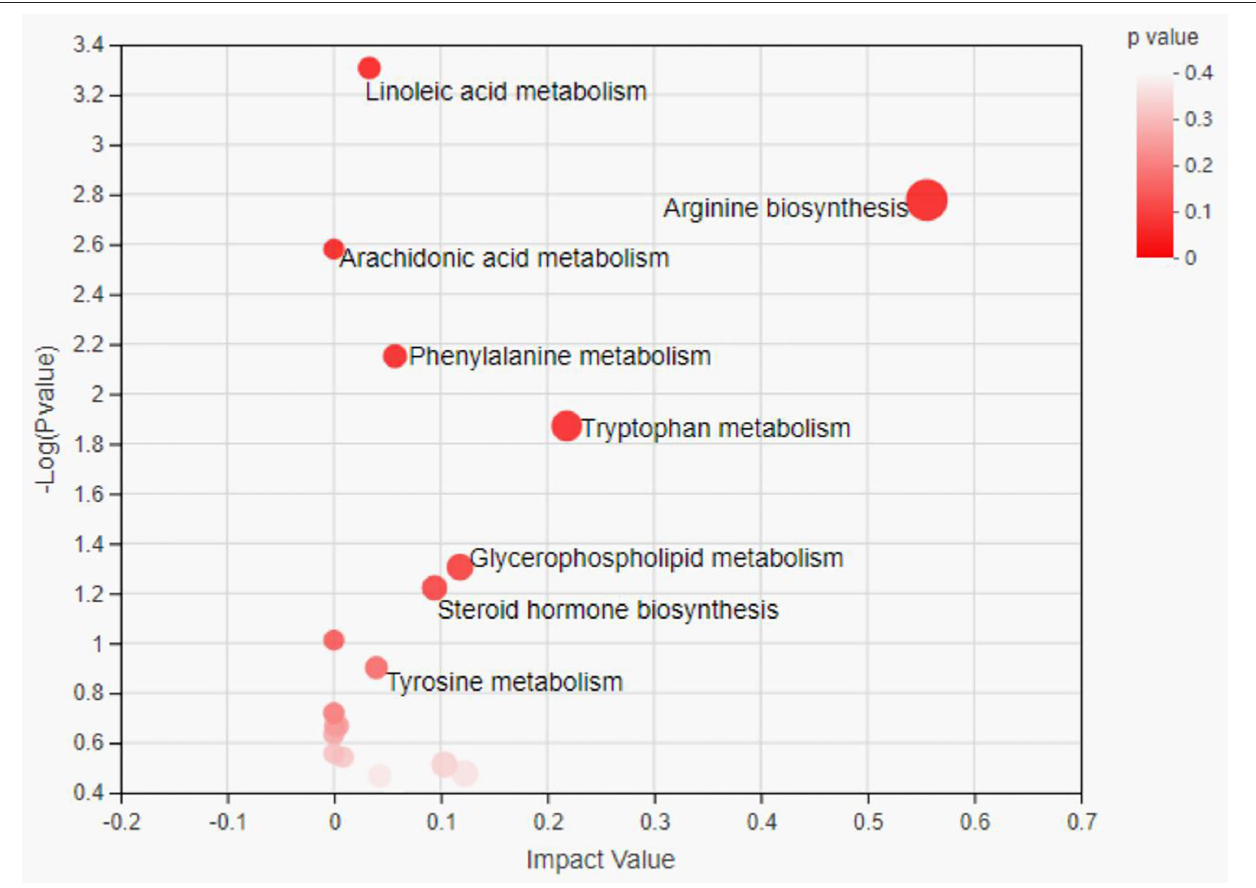
FIGURE 3 | Pathway analysis of differential metabolites in serum samples between the two group heifers. Each bubble in the bubble map represents a metabolic pathway. The x-axis represents a pathway impact value in the topology analysis, and larger bubbles represent higher pathway impact values. The y-axis represents the P -value (–Log p ) of the metabolic pathway in the enrichment analysis, and the darker color of bubble represents higher pathway enrichment.